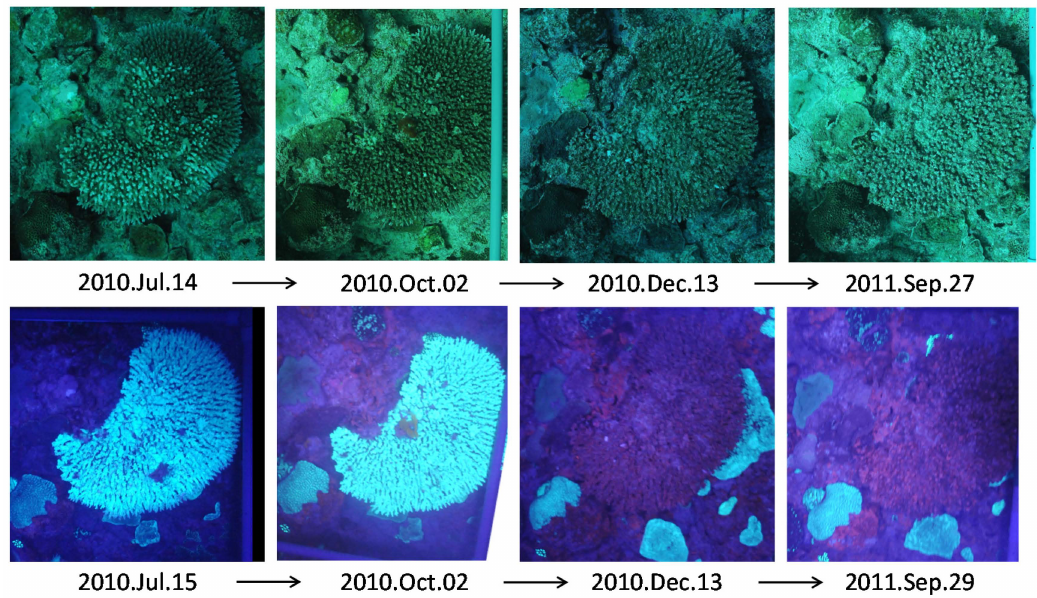
Figure 2. Day-time photographs ( upper four photographs ) and night-time UV—induced fluorescence photographs ( lower four photographs ) of the same damaged coral colony in July, October, December 2010, and September 2011. The fluorescence property of this coral colony disappeared due to dissolution of fluorescent proteins between October and December